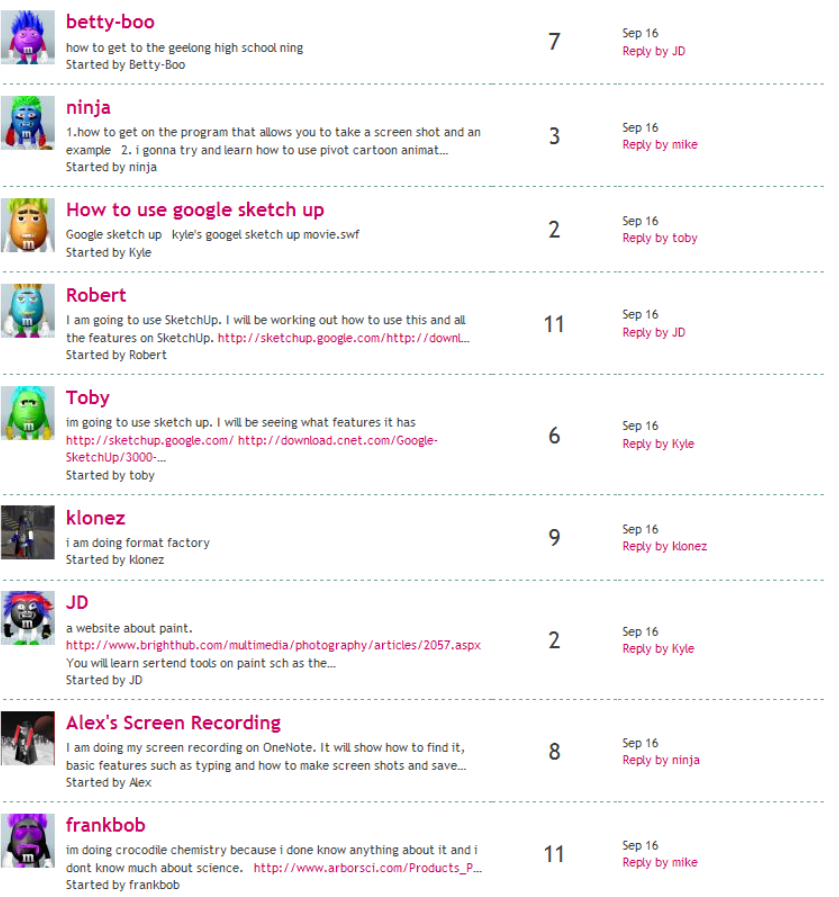
Figure 6. Screen clip showing the number of replies some students received after giving constructive feedback and support to one